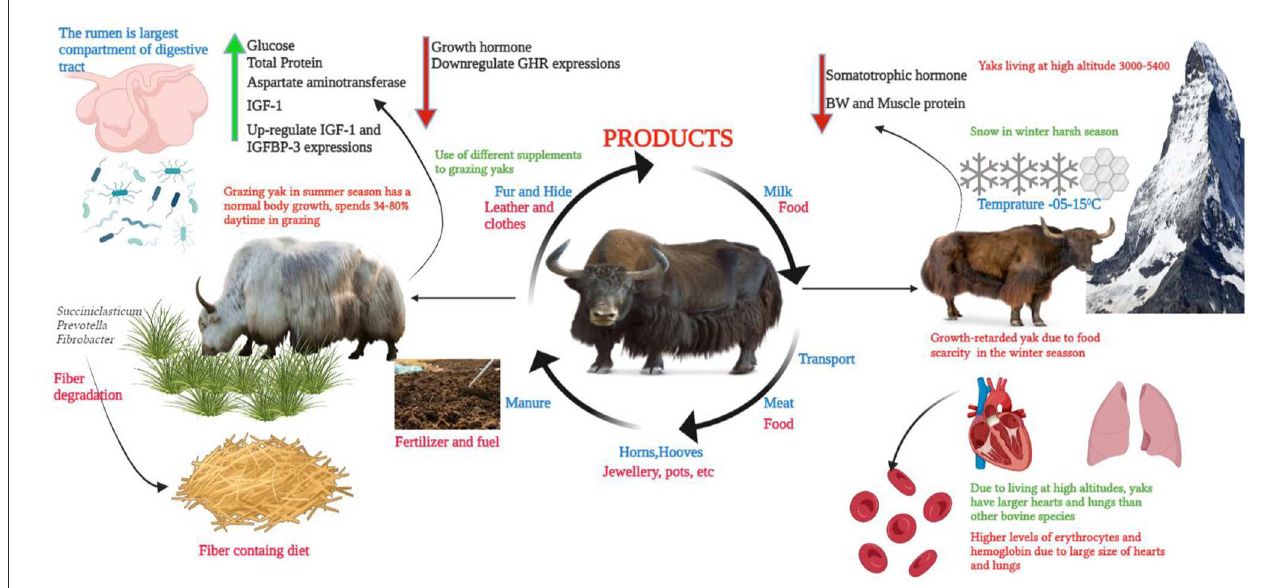
FIGURE1 A brief diagram of the domestication, feeding, microbiota, and harsh environment of the QTP.